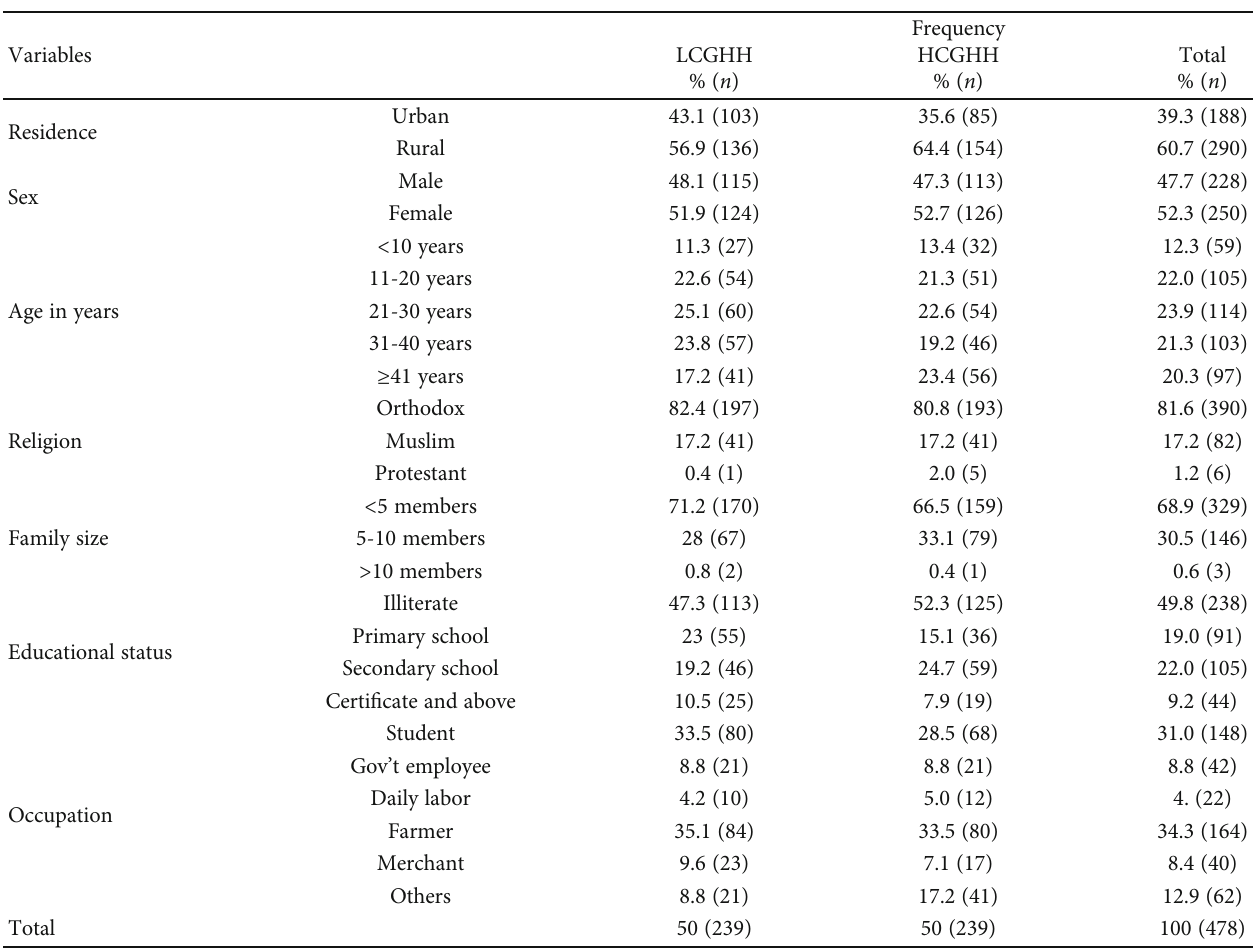
Table 1: Socio-demographic characteristics of study participants in low and high coverage of graduated household districts, Northwest Ethiopia,